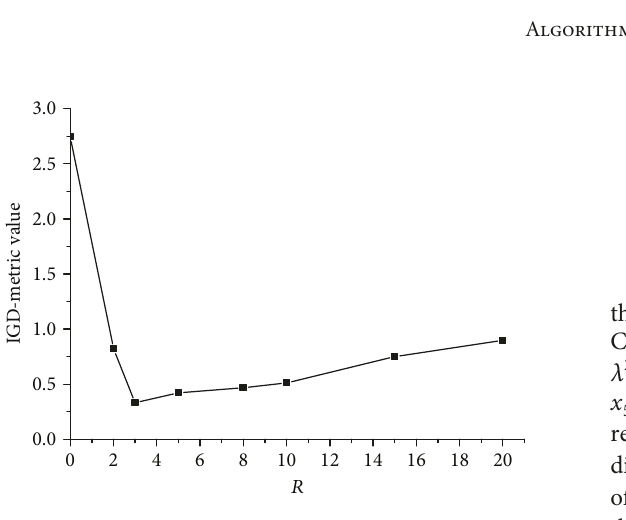
Figure 7: The e ff ect of di ff erent R